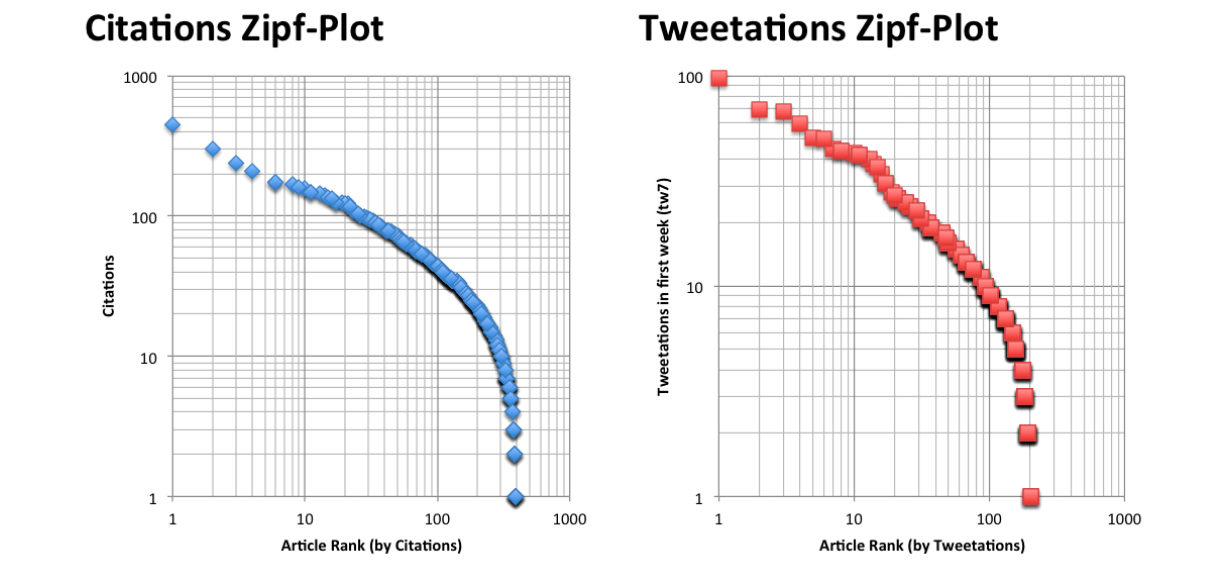
Figure 7. Left: Zipf plot for JMIR articles 3/2000-12/2009 (n=405), with number of citations (y-axis) plotted against the ranked articles. Right: Zipf plot showing the number of tweetations in the first week (tw7) to all JMIR articles (n=206) published between April 3, 2009 and November 15, 2011 (y-axis) plotted against the ranked articles. For example, the top tweeted article got 97 tweetations, the 10th article got 43 tweetations, and the 102th ranked article got 9 tweetations.